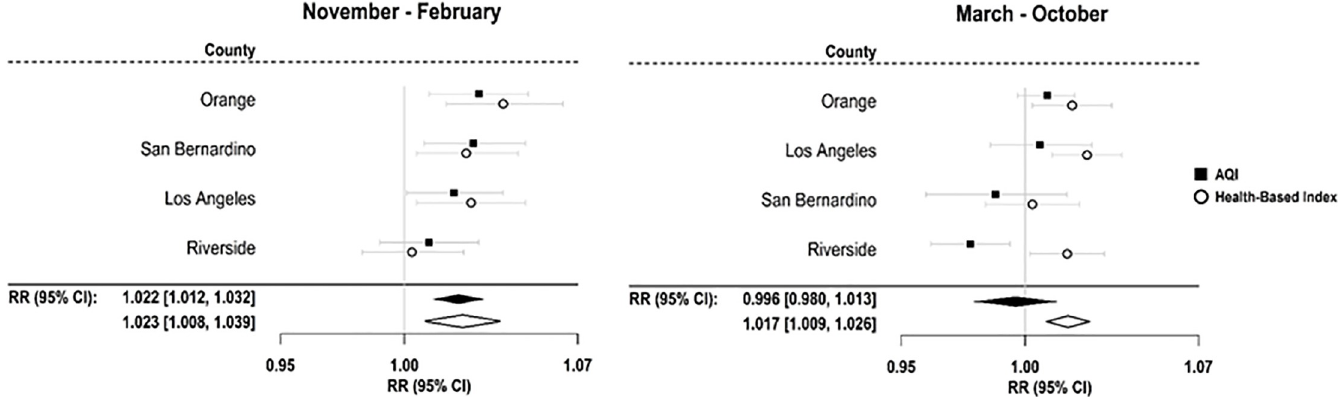
Fig 4. Results of an applied policy analysis showing relative risks of respiratory ED visits for health-based index vs. AQI in the Southcoast Air Quality Management District in Southern California from 2012–2014. Relative risks are presented per IQR increase of the index value. Abbreviations: AQI, air quality index; IQR, inter-quartile range; RR, relative